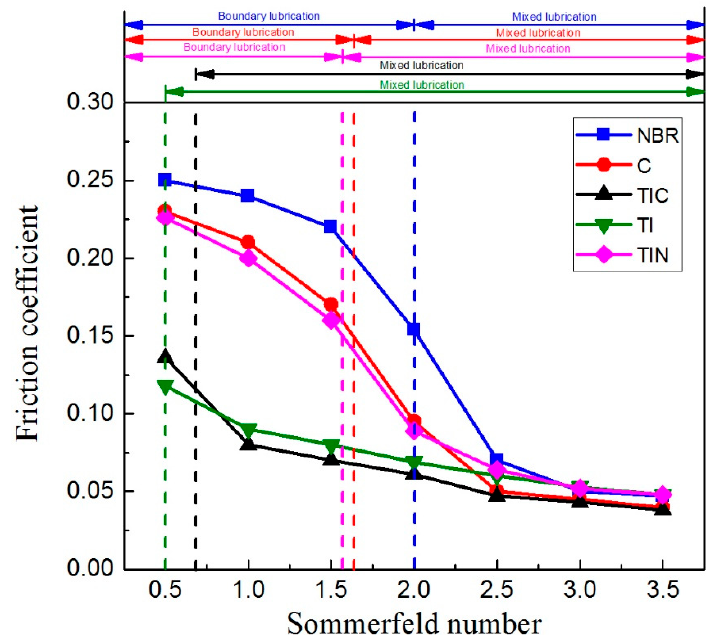
Figure 13. Stribeck curves of (Ti:N)-GLC films at 100 W.